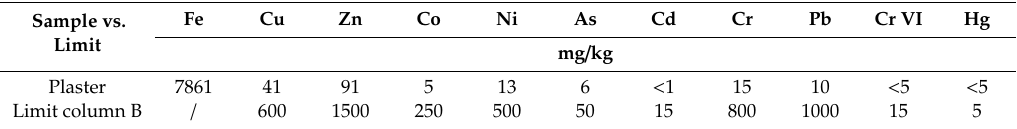
Lgs.D. 152 / 2006, Annex 5, title IV and Art. 8 of M.D. 05 / 02 / 1998.